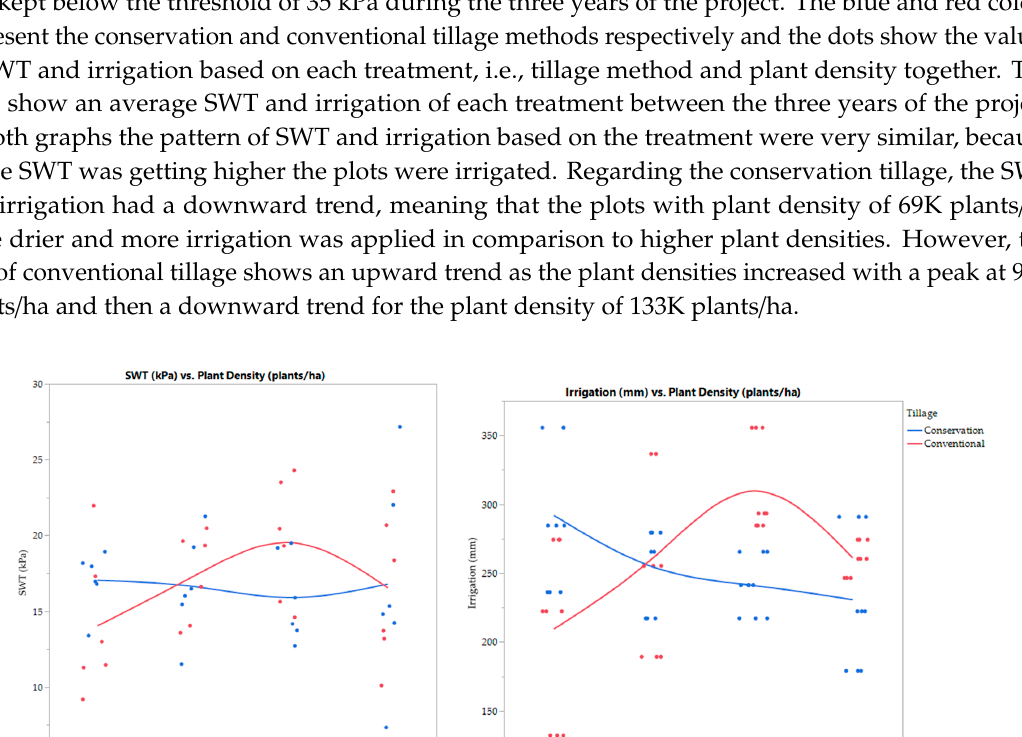
Figure 8. Daily average SWT data for ( a ) 69,000 plants/ha, ( b ) 88,000 plants/ha, ( c ) 99,000 plants/ha,